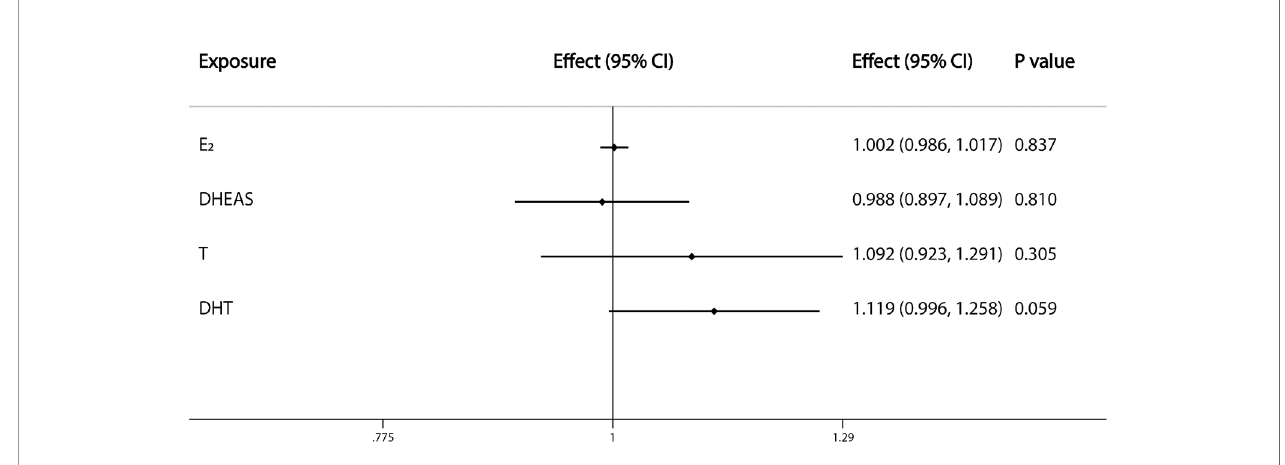
FIGURE 1 | Causal effects of sex steroids on the risk of overall OA. The estimated effects, 95% con fi dence intervals and p-values of associations were contained. Effect, the combined causal effect; CI, con fi dence interval; P value, p-value of the causal